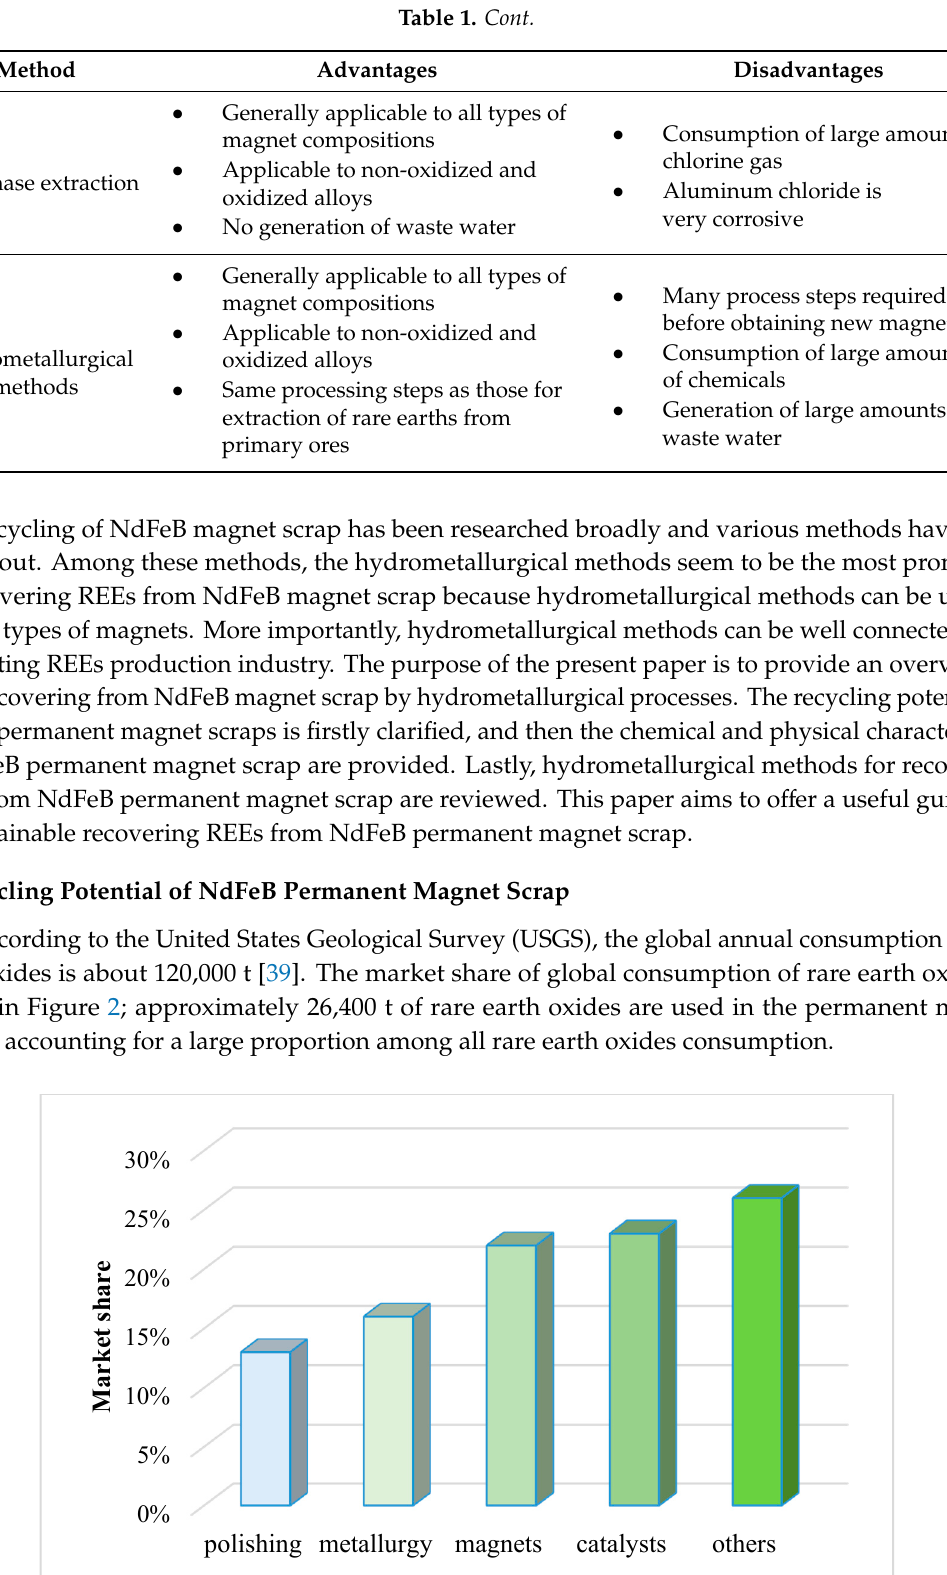
Figure 3. Predicted growths of market share of global rare earth elements (REEs) consumption [40]; published by American Chemical Society, 2012. Schulze et al. [41] calculated the NdFeB demand for magnets used in different application groups and net availability of secondary NdFeB supply from End-of-Life (EOL) magnets from 2020 to 2030 based on low and high NdFeB demand scenario. As shown in Figure 4, the demand of NdFeB and the net availability of secondary NdFeB supply from EOL magnets both increase gradually. The demand of NdFeBis about 240 kt and 633 kt in 2030 for the low and high NdFeB demand scenario, respectively. Meanwhile, the net availability of secondary NdFeB supply from EOL magnets is about 27 kt and 54 kt in 2030 for the low and high NdFeB demand scenario, respectively. Obviously, the recovery of NdFeB magnets possesses huge potential value.